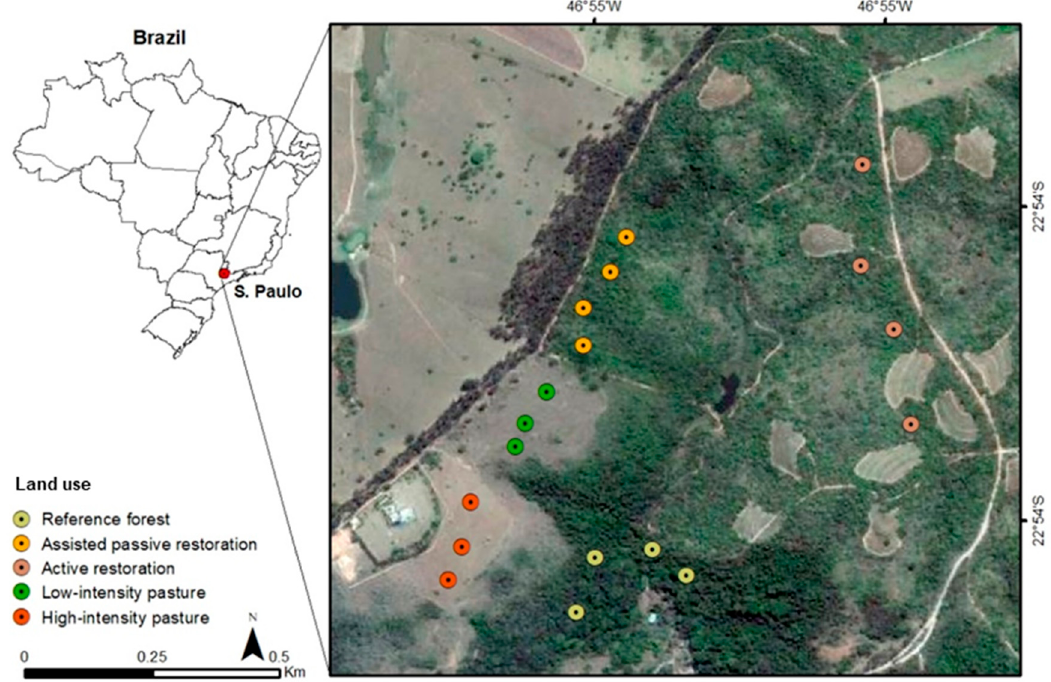
Figure 1. Location of the 18 study plots in the state of São Paulo, Southeast Brazil.